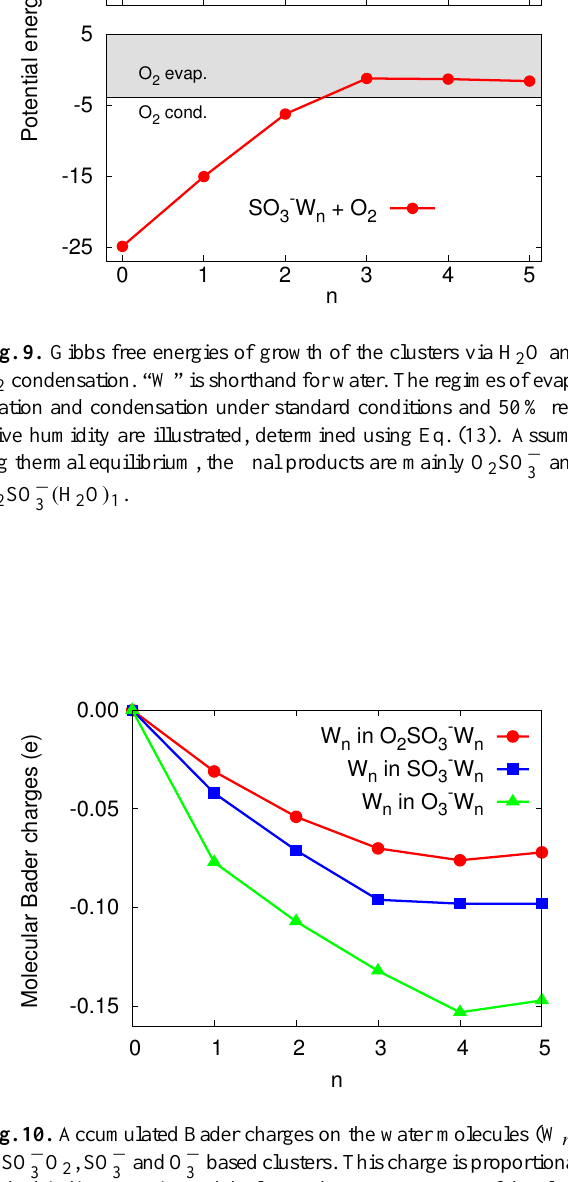
Fig. 10. Accumulated Bader charges on the water molecules (W n ¯ ) in SO − O 2 , SO − and O − based clusters. This charge is proportional 3 3 3 to the binding energies and the larger the non-water part of the clus- ter, the less charge on the water molecules and hence, the weaker the